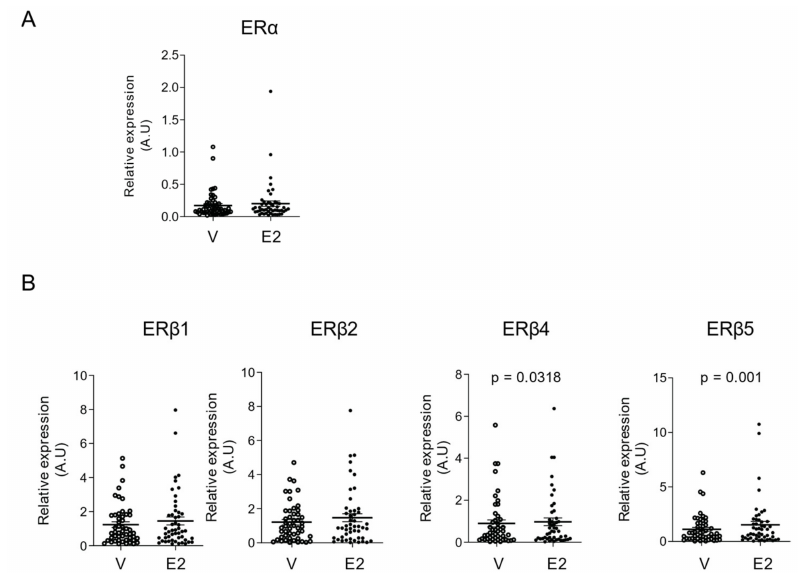
Figure 3. E2 selectively stimulates ER β 4 and ER β 5 isoforms’ mRNA abundance in hGCs. Cells were treated with solvent vehicle (V) or 10 nM E2 for 24 h. mRNAs were extracted and mRNA levels of ER α ( A ) and ER β (1, 2, 4, and 5) isoforms ( B ) were measured relative to that of GAPDH by RT- qPCR. E2 significantly stimulates the relative transcript levels of ER β 4 and ER β 5 isoforms ( n = 49). Values are represented as means ± SEM from two or three identical wells per patient, measured in triplicate. Statistical analysis was performed by the two-side Wilcoxon signed ranks test. A.U., Arbitrary